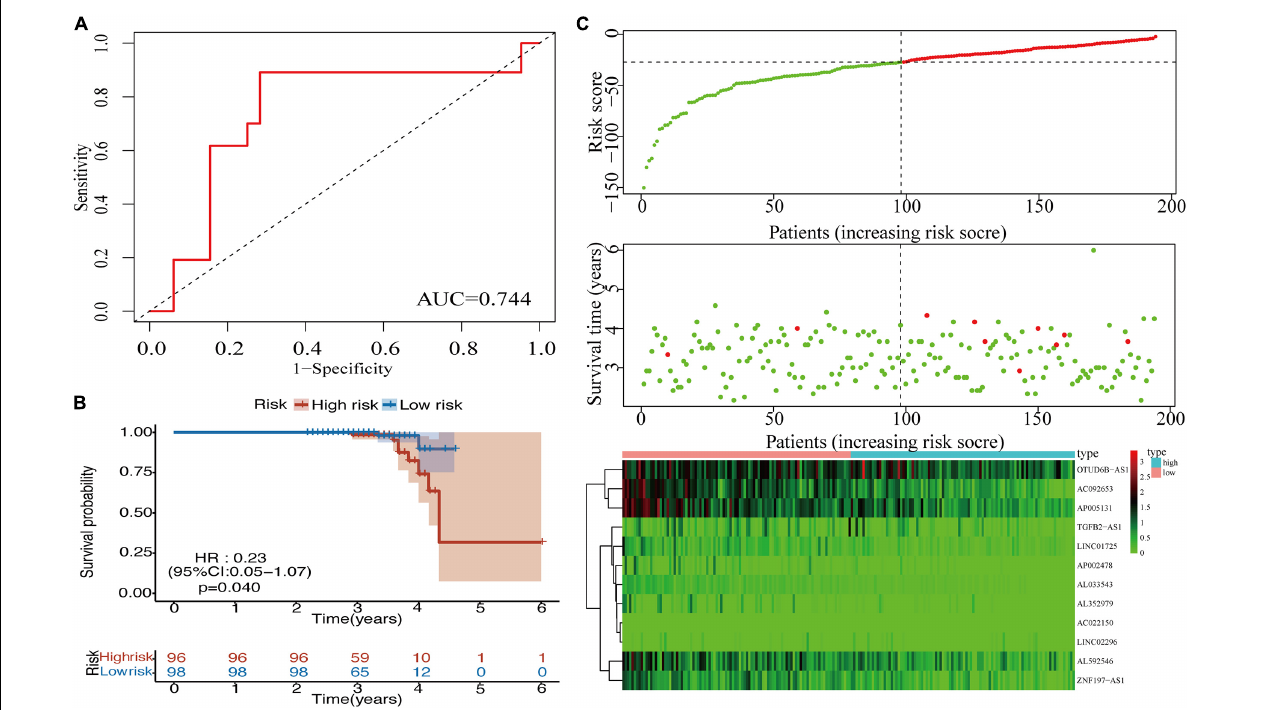
FIGURE 5 | (A) ROC curve for the 12 lncRNAs in the external validation cohort. (B) Kaplan–Meier curve of OS for BRCA patients in the external validation cohort. (C) Heatmap, distribution of risk scores, and survival status in the external validation cohort. ROC, receiver operating characteristic; lncRNAs, long non-coding RNAs; OS, overall survival; BRCA, breast